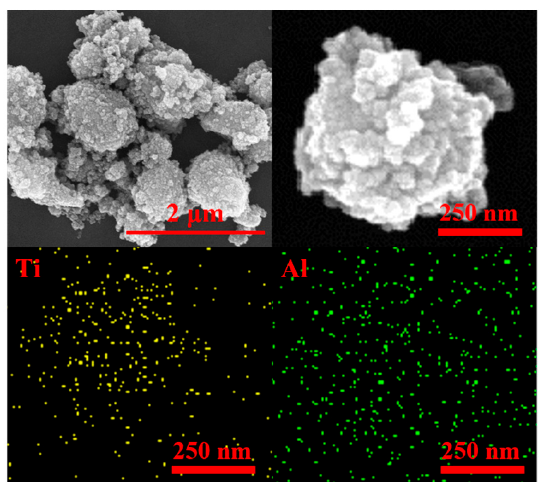
Figure 3. SEM images and EDS analysis of alumina-doped titanium dioxide